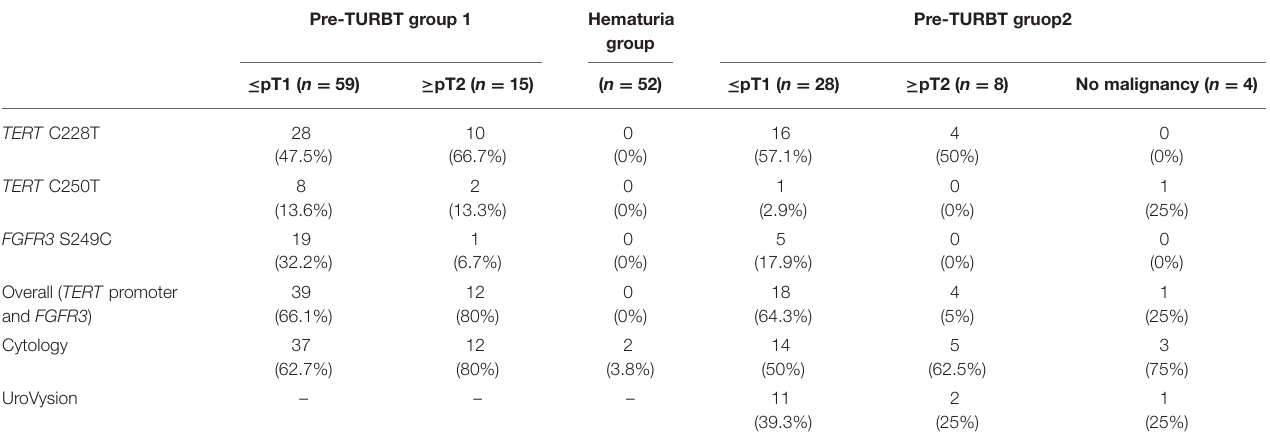
TABLE 2 | Positive rate of urinary cell-free DNA, urine cytology, and UroVysion for pre-TURBT group 1,2 and hematuria group. Pre-TURBT group 1 Hematuria Pre-TURBT group